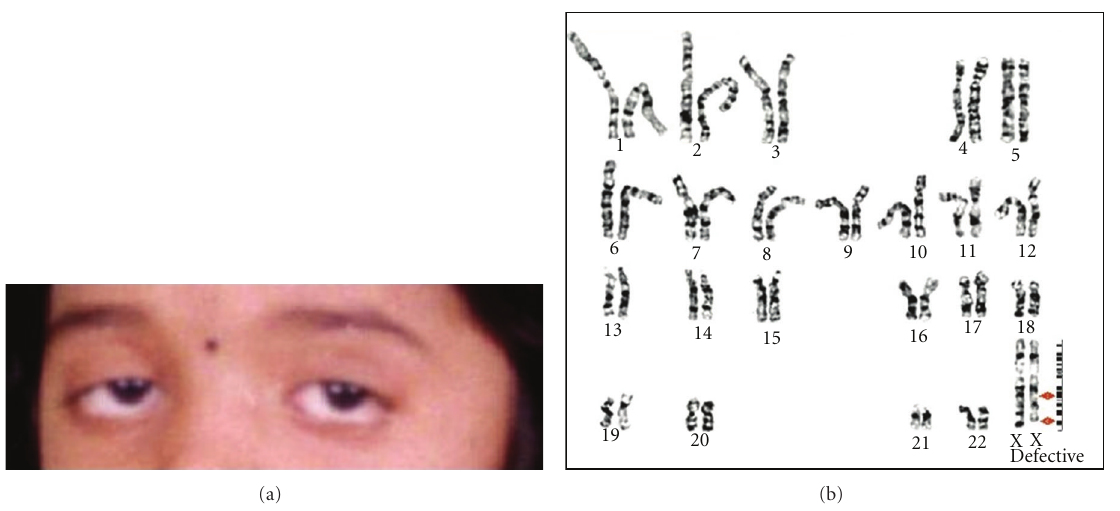
Figure 1: (a) Photograph of the patient with BPES showing peculiar ocular deformities. (b) GTG-banding results showing two break points on one of the X